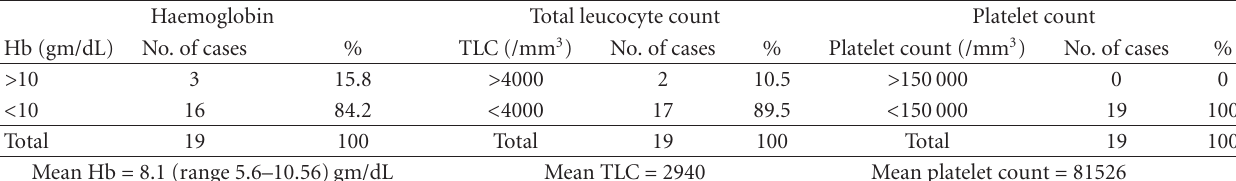
Table 4: Hematological profile of epistaxis patients.